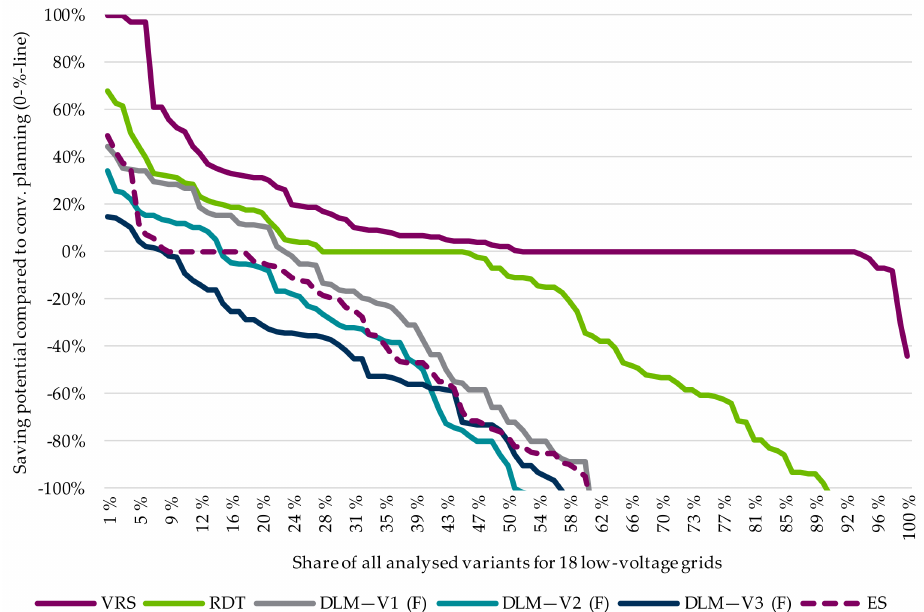
Figure 19. Savings potential related to the conventional planning variant as a reference variant consolidated across all innovative planning variants for 18 low-voltage grids, note: not shown further than −